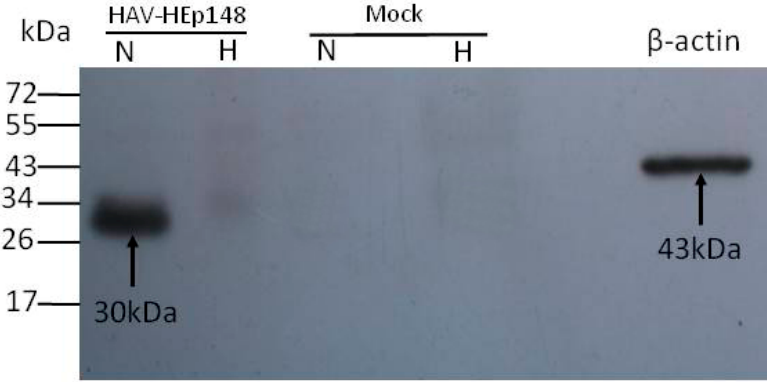
Figure 4. Western blot analysis of the HEp148 antigen expressed by HAV-HEp148 virus in Huh-7 cells. The cell extracts were separated by 12% PAGE gel, proteins were transferred onto nitrocellulose membranes and probed with anti-HEV capsid rabbit polyclonal antibodies. HAV-HEp148: HAV-HEp148 infected samples. Mock: Mock-infected samples. N: samples were not heated. H: samples were boiled for 10 min. Molecular mass markers are shown in kDa on the left margin. HEp148 protein dimer (30 kDa) and β -actin (43 kDa) are indicated by arrowheads.